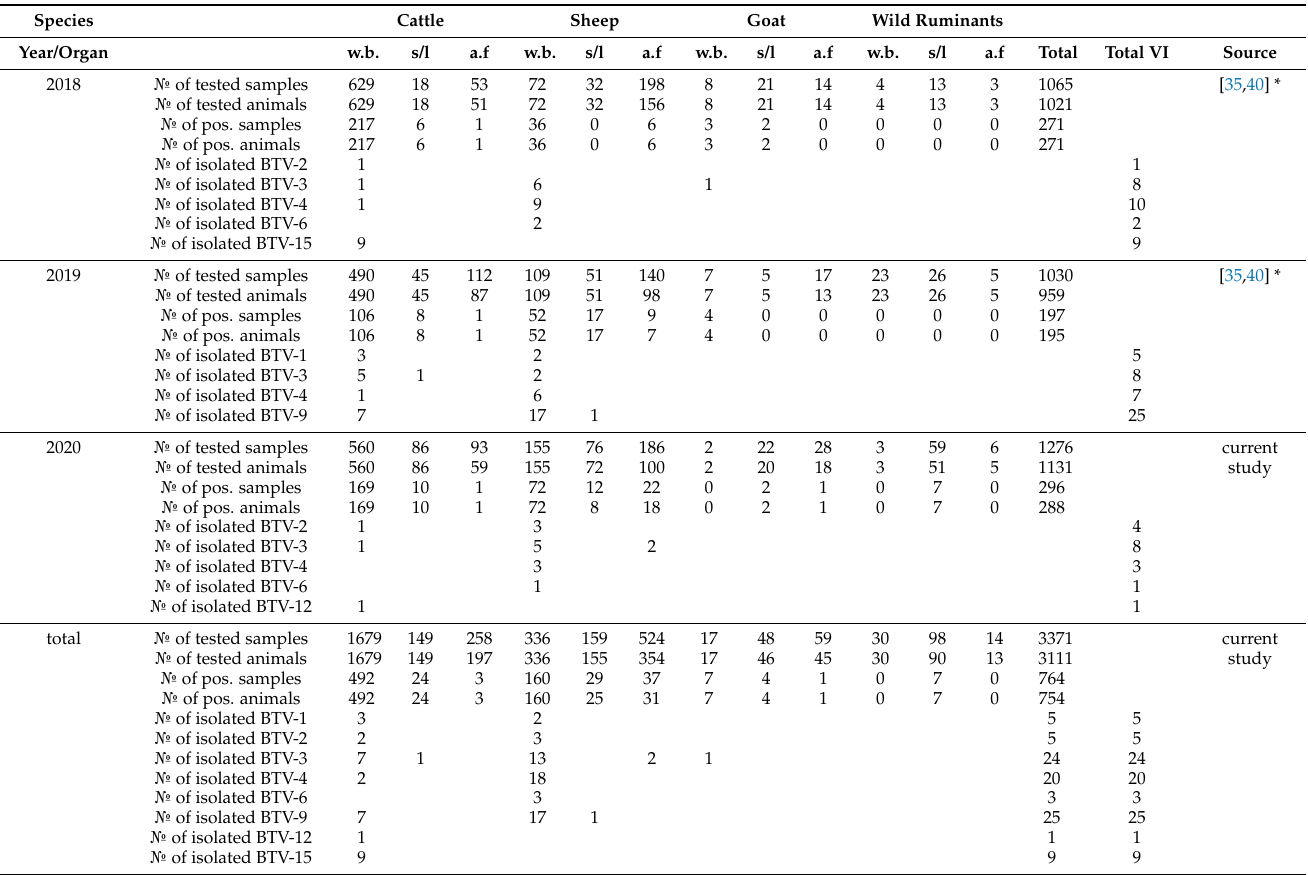
Table 1. Pan-BTV RT-qPCR and BTV isolation from different kinds of domestic and wild/zoo ill or dead animals tested from